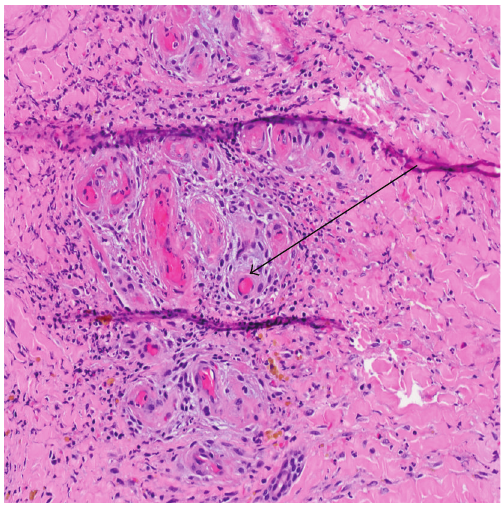
Figure 1: Biopsy of patient 7 showing fibrin occlusive vasculopathy